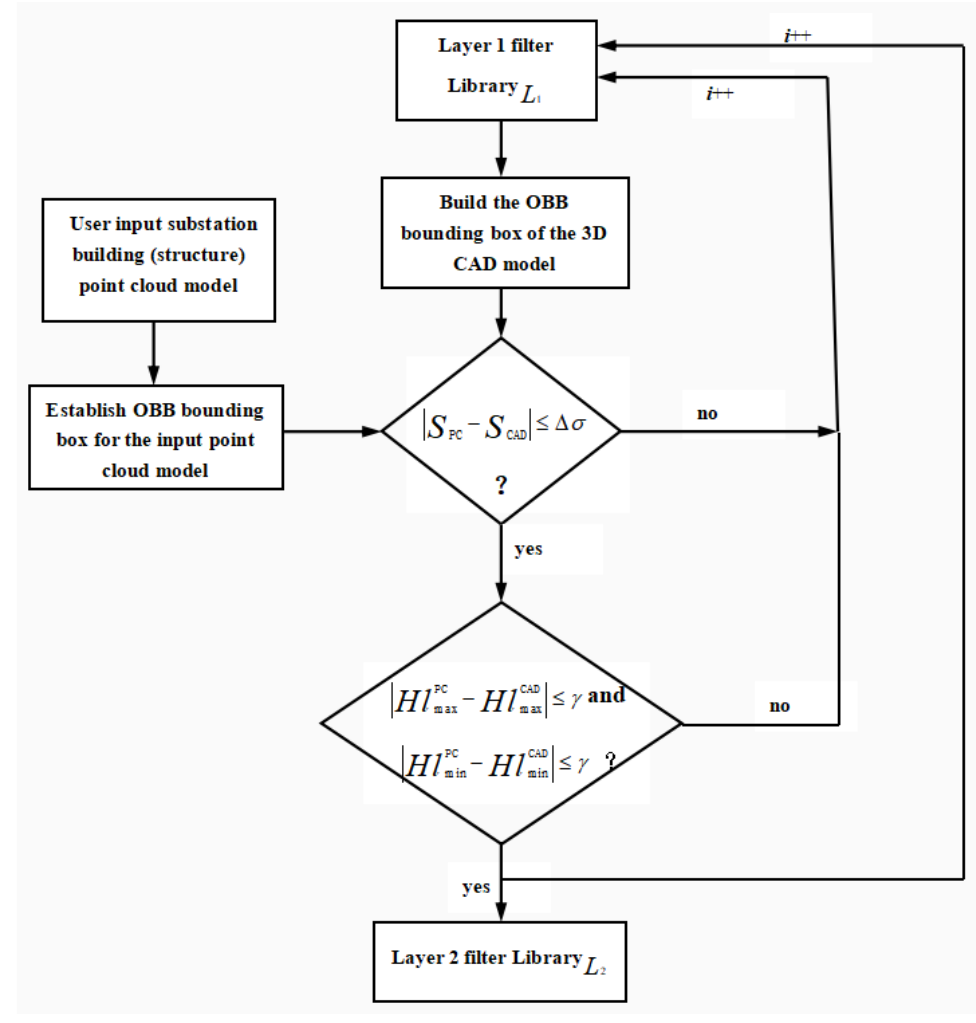
Figure 4. Model screening based on the bounding sphere.